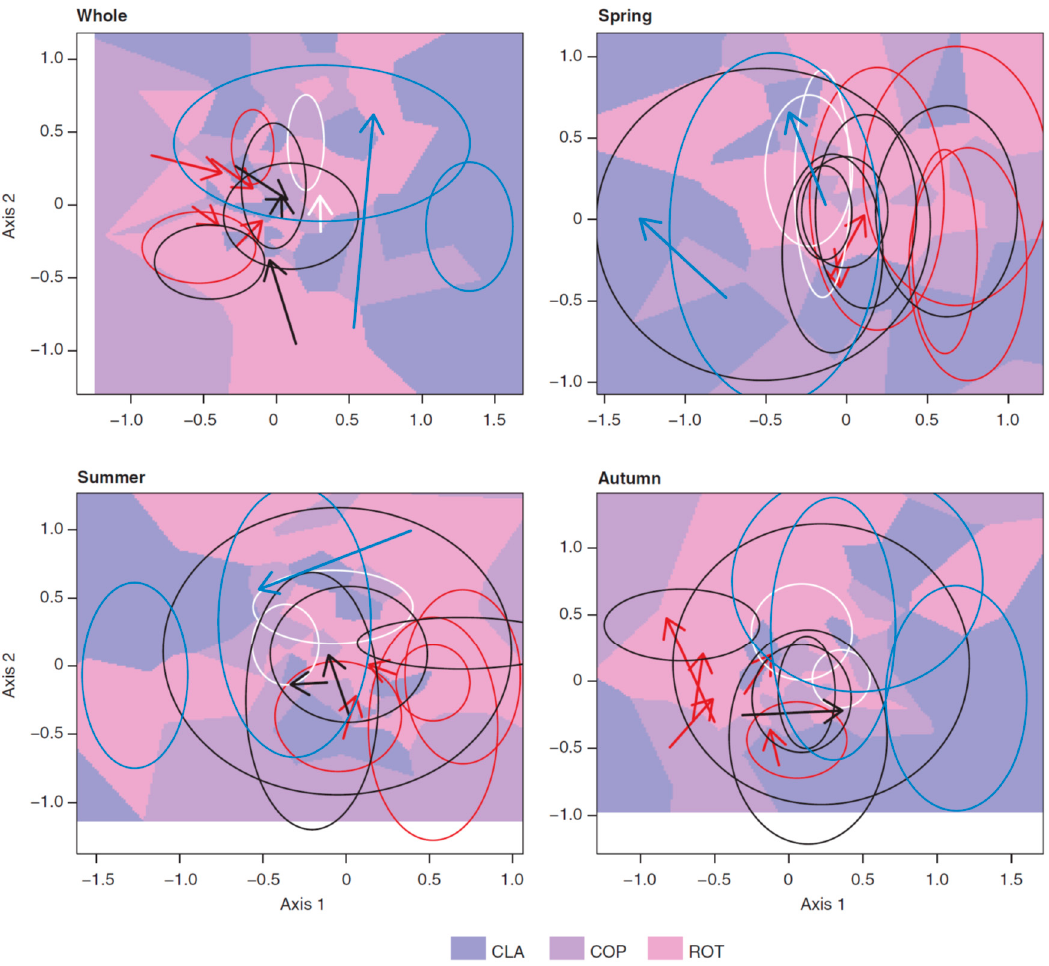
Figure 7. NMDS ordination of annual and seasonal zooplankton assemblages. See Figures 4 and 6 for details.